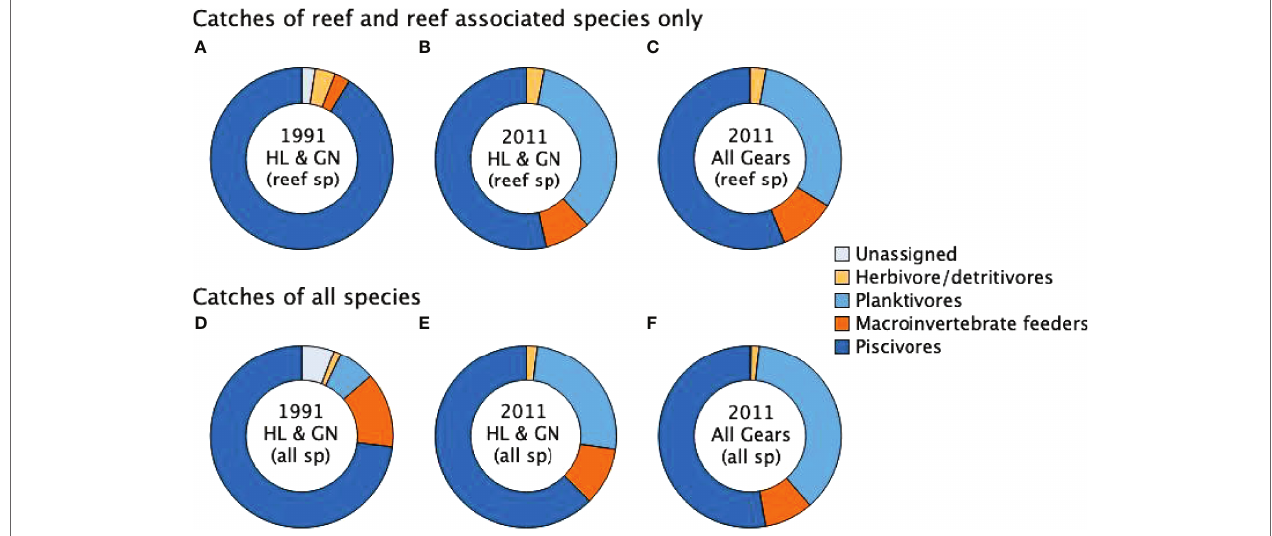
FIGURE 4 | Change in the proportional contribution of fish from each trophic group between 1991 reported by Laroche et al. (1997) and 2011. (A) reef fish only reported by Laroche et al. and compares with (B) 2011 reef fish catches for handline and gillnets only, and (C) 2011 reef fish catches for all gear types.